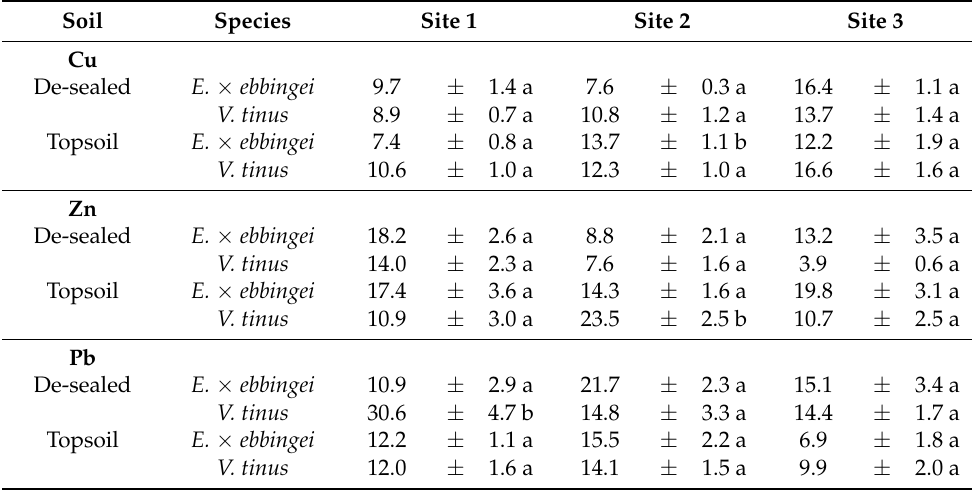
Table 4. Heavy metal concentrations ( µ g g − 1 d.w.) in leaf samples after two years of plant cultivation in de-sealed and topsoil at T1. Significant differences (at least p < 0.05) are shown by different small letters for comparison between de-sealed and topsoil within the same